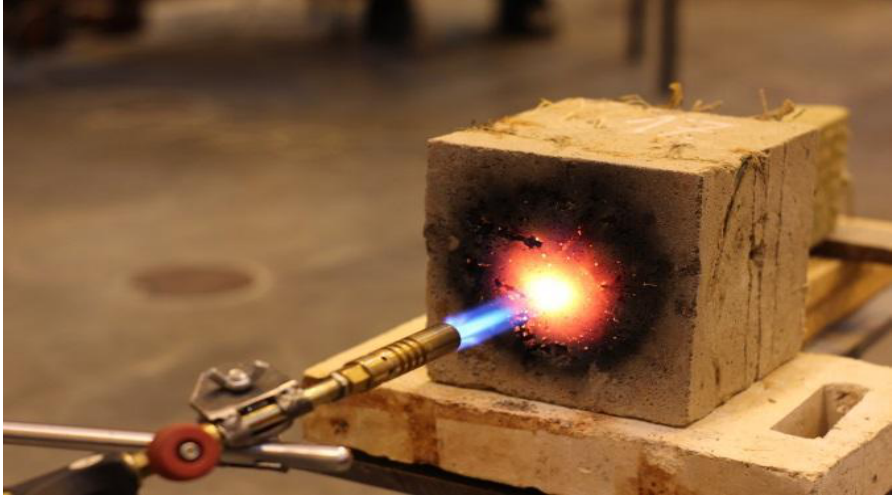
Figure 3. Test rig during fire resistance measurements.